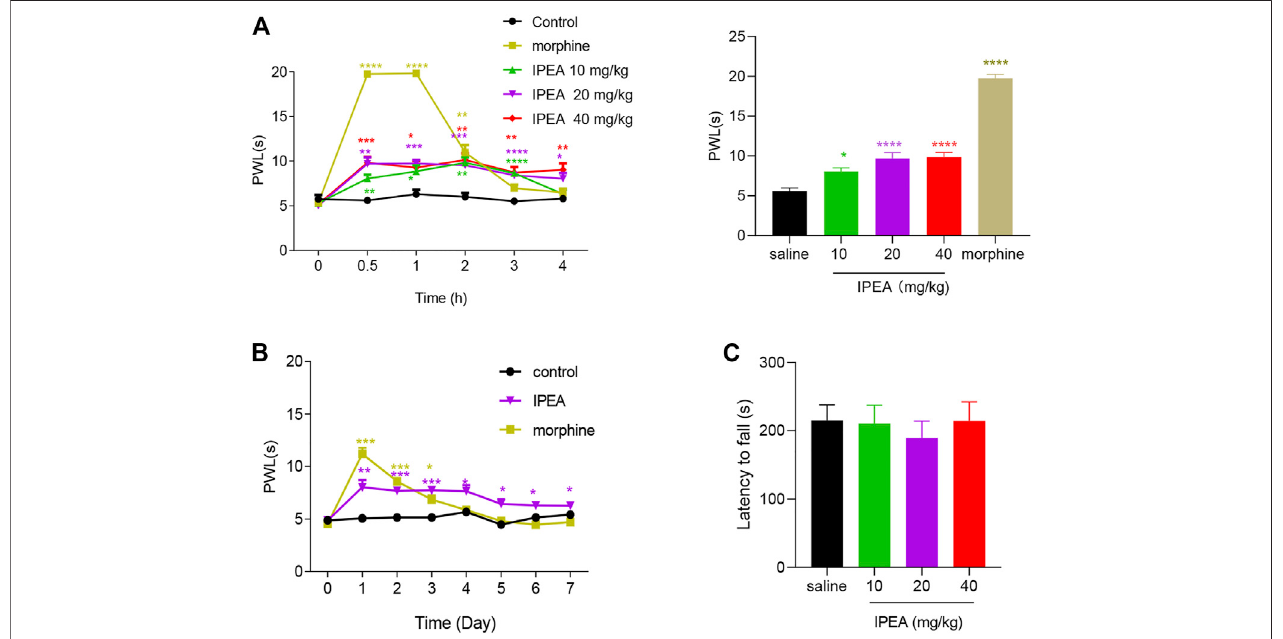
FIGURE 1 | Anti-nociceptive effects of IPEA in acute pain model. (A) Left: time course of PWL with different doses of IPEA treatment in the hot plate assay. Two- wayANOVArevealedsigni fi cantdrugeffects(F4,31 (cid:2) 68.02, p < 0.0001)andtimeeffects(F4.093,126.9 (cid:2) 91.44, p < 0.0001)followedbyDunnettposthoctest. Right: dose-response effect of IPEA on PWL 30 min after administration. One-way ANOVA revealed signi fi cant drug effects (F4, 31 (cid:2) 93.45, p < 0.0001) (B) Lack of antinociceptive tolerance of IPEA (20 mg/kg). Repeated i. p. injections of 20 mg/kg for seven consecutive days, and PWL was measured 1 h after drugs injection. Morphine was 5 mg/kg. Two-way ANOVA revealed signi fi cant drug effects (F2, 14 (cid:2) 31.02, p < 0.0001) and time effect (F4.015,56.02 (cid:2) 37.69, p < 0.0001) followed by Dunnettposthoctest (C) EffectofIPEAinrotarodassay.One-wayANOVAwasused.Datawerepresentedasthemean ± SEM( n (cid:2) 7-8micepergroup).* p < 0.05,** p < 0.01, *** p < 0.001, **** p < 0.0001 vs Control